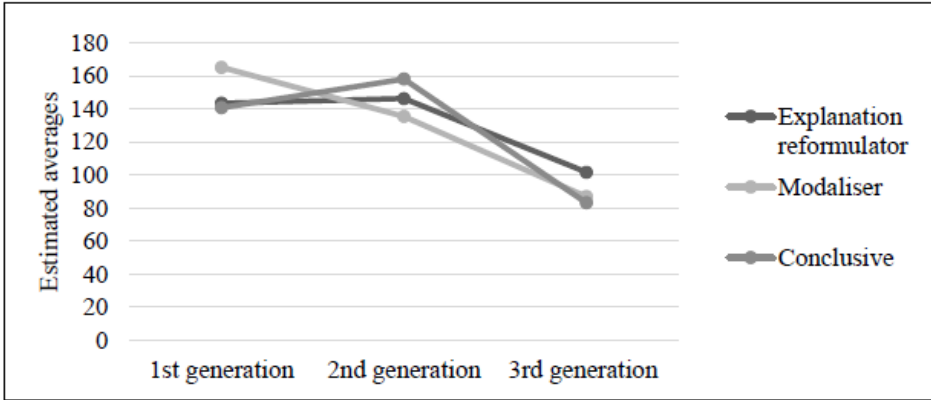
Figure 6. Estimated averages of the functions of vamos according to the generational group of speakers.